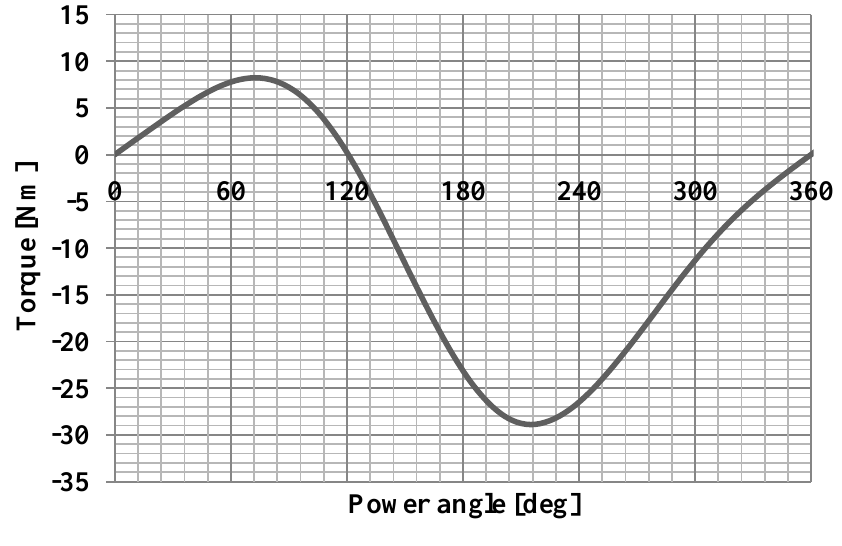
Figure 6. The characteristics of torque as a function of the power angle.